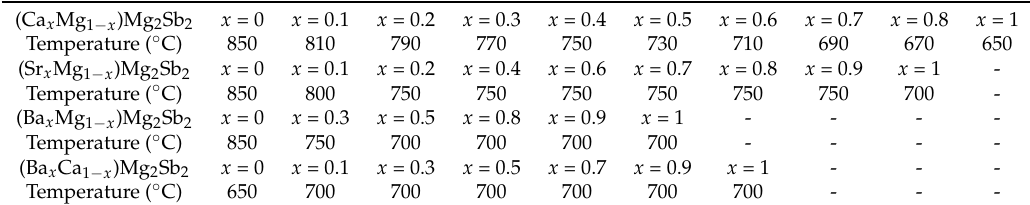
Table 1. The SPS temperatures of (Ca x Mg 1 − x )Mg 2 Sb 2 , (Sr x Mg 1 − x )Mg 2 Sb 2 , (Ba x Mg 1 − x )Mg 2 Sb 2 ,